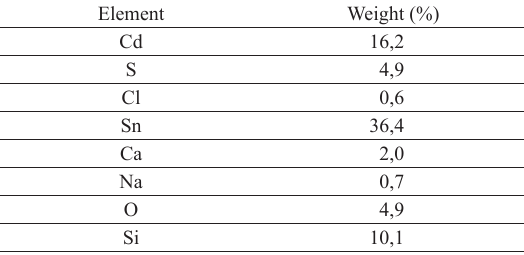
Table 4. CdS Film composition.